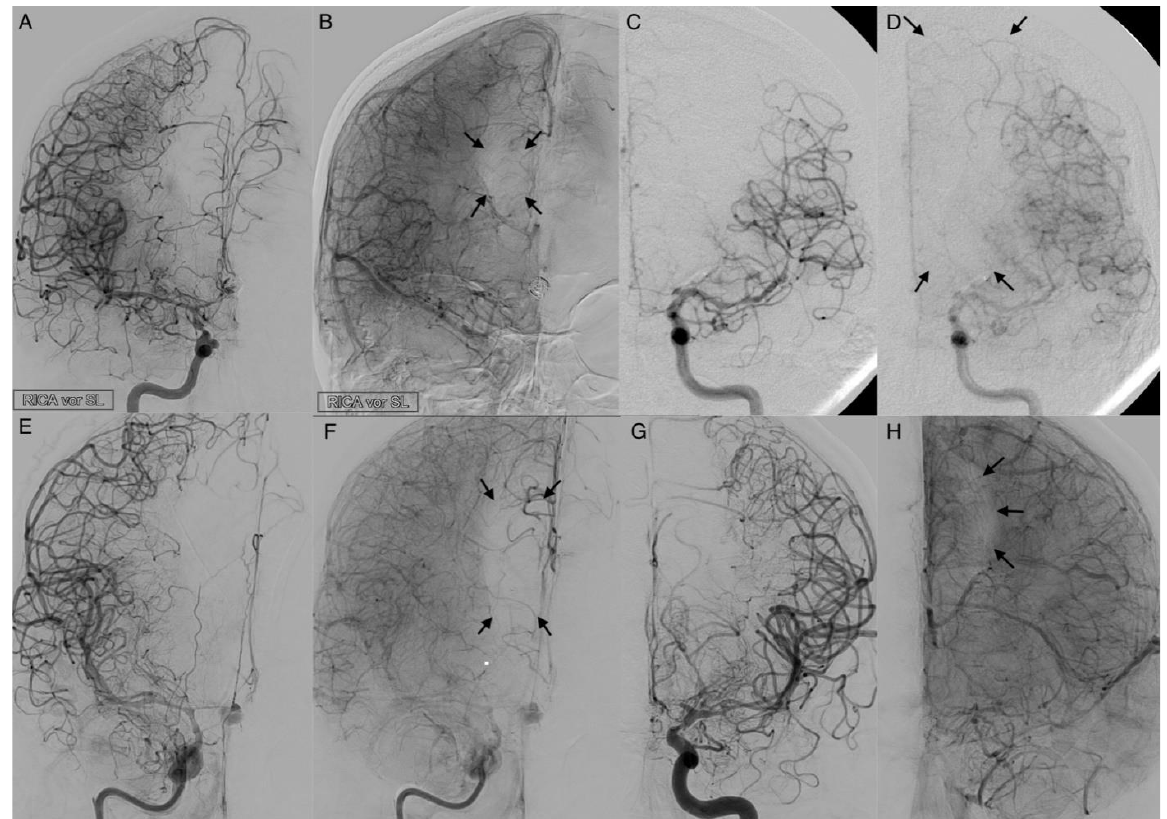
Figure 5. Activated leptomeningeal collaterals in anterior cerebral artery vasospasm. The angiograms show the extent of collateralization in four cases of severe cerebral vasospasm following aneurysmal subarachnoid hemorrhage. The arterial phase ( A , C , E , G ) reveals a strongly narrowed and decelerated anterior cerebral artery. In the parenchymal phase ( B , D , F , H ), activated leptomeningeal collaterals of the middle cerebral artery took over the retrograde supply of the decelerated parenchyma with varying extent of the remaining perfusion defect (arrows).